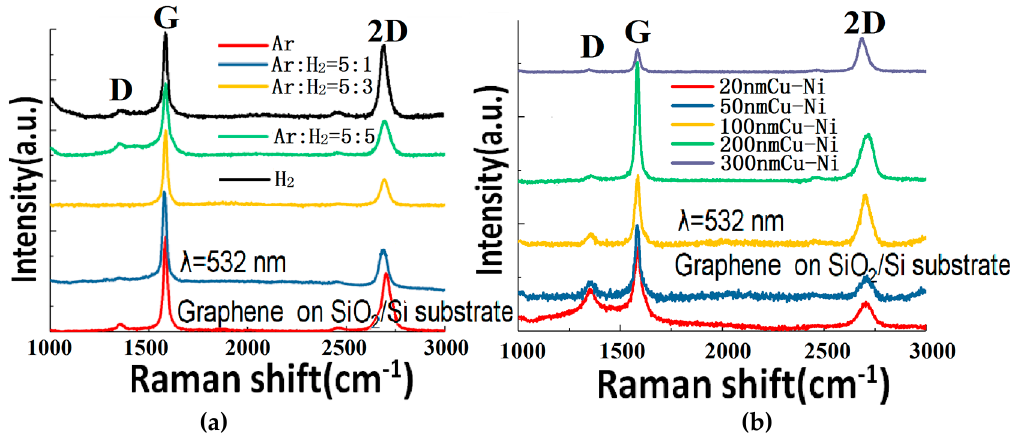
Figure 5. (a) Raman spectra of the graphene thin films grown with different gas ratios at 900 °C on Figure 5. ( a ) Raman spectra of the graphene thin films grown with di ff erent gas ratios at 900 ◦ C on 300 nm Cu-Ni and transferred to SiO 2 /Si substrates. (b) Raman spectra of the graphene grown at 900 300 nm Cu-Ni and transferred to SiO 2 / Si substrates. ( b ) Raman spectra of the graphene grown at °C (transferred to SiO 2 /Si) and Ar:H 2 (5:1) gas ratio with different thicknesses (from 20 to 300 nm) of 900 ◦ C (transferred to SiO 2 / Si) and Ar:H 2 (5:1) gas ratio with di ff erent thicknesses (from 20 to 300 nm) of Cu-Ni Cu-Ni alloy